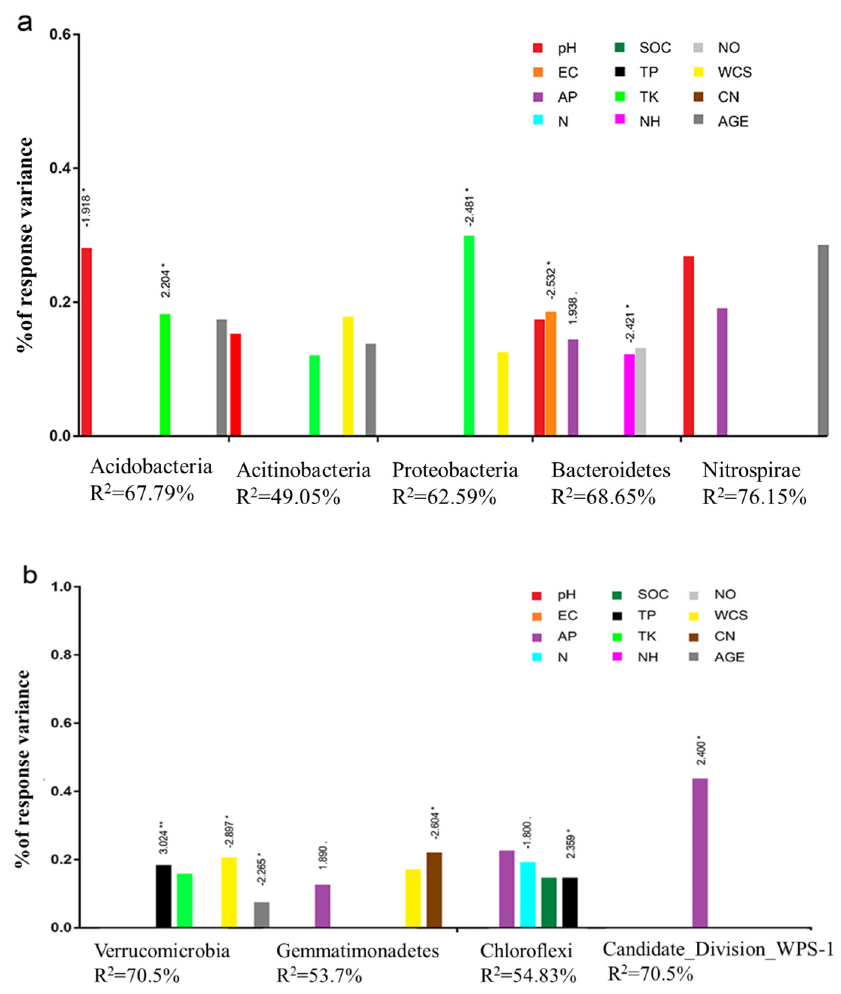
Figure 5. Relative importance of the significant independent variables explaining the variance in abundance of the different taxonomic groups (( a ), major bacterial phyla for Acidobacteria, Proteobacteria, Actinobacteria, Bacteroidetes and Nitrospirae; (b), major bacterial phyla for Verrucomicrobia, Gemmatimonadetes, Chloroflexi and Candidate_division_WPS-1). Partial regression coefficients are written on the bars and shown only for statistically significant variables of pH, soil pH; EC, electrical conductivity; SOC, soil organic carbon; TN, total nitrogen; NH 4+ -N, ammonium; NO 3- -N, nitrate; TP, total phosphorus; AP, available phosphorus; TK, total potassium; AK, available potassium; WCS, soil water content; AGE, rehabilitation age; CN, soil C/N ratio. N = 32 for all groups expect two in shrub-grassland number 8 and coniferous broad-leaved. Number 8, for which n = 30. · , p <